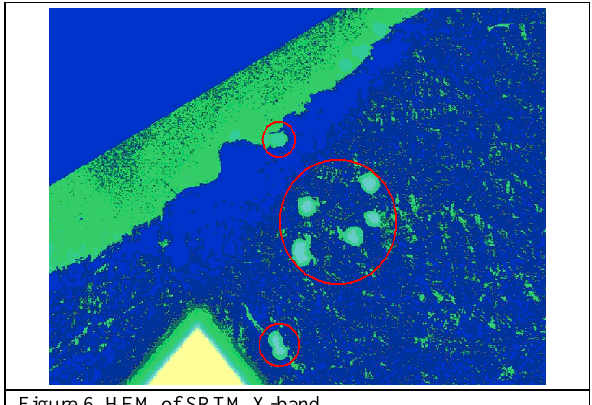
Figure 6. HEM of SRTM X-band. The red circles show areas with problems caused by large terrain inclination. The upper circle covers a steep build up